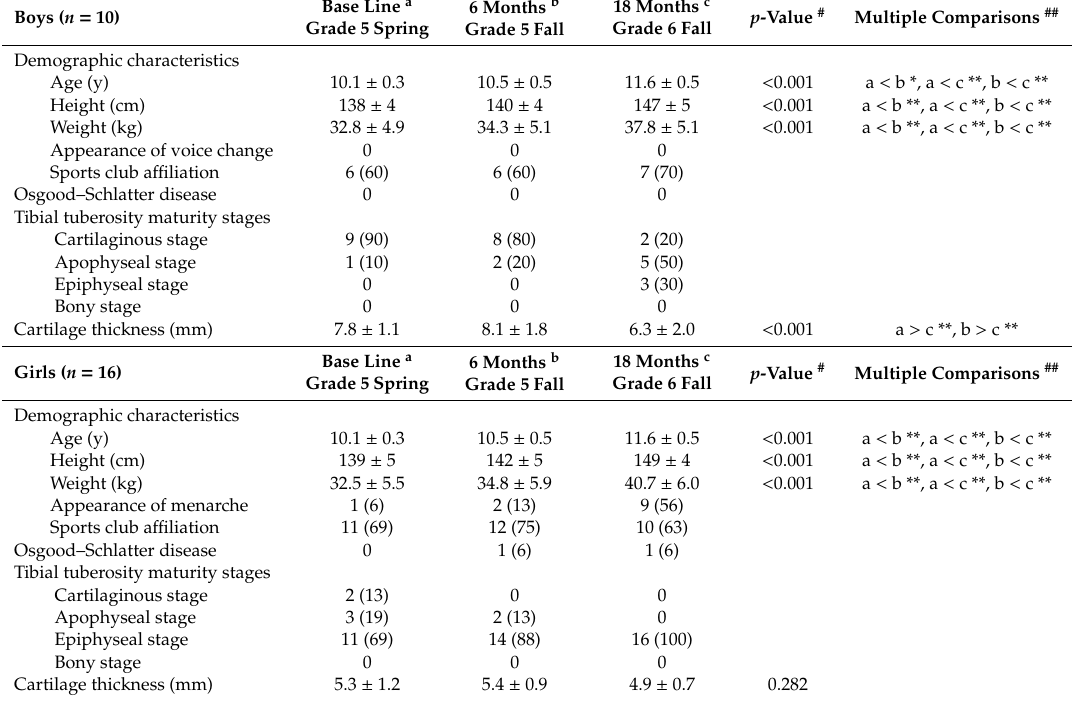
Table 4. Demographic characteristics, Osgood–Schlatter disease, tibial tuberosity maturity stages, and cartilage thickness at the tibial tuberosity at each examination time point of the longitudinal study in 26 higher elementary grade schoolchildren by